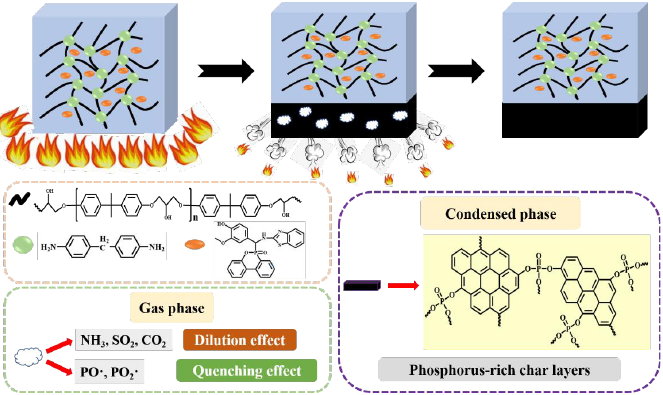
Figure 12. The flame-retardant mode of action of AVD on